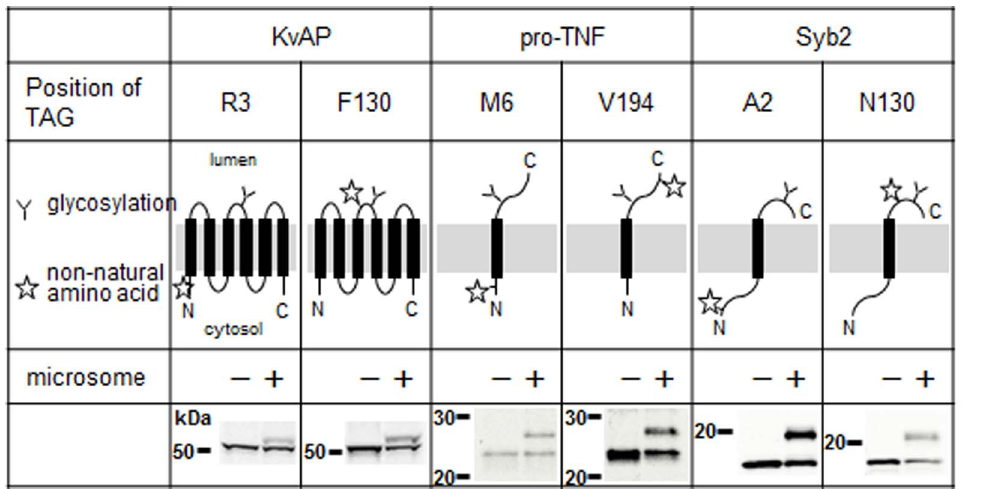
Fig. 6. Position-specific incorporation of fluorescent amino acids by the cell-free system. RNA templates encoding variants of KvAP, pro-TNF, or Syb2 were translated in the cell-free system supplemented with BODIPYFL-AF conjugated tRNA with or without the addition of Sf21microsomes (microsomes). The non-natural amino acids were incorporated into introduced TAG codon. The resulting proteins were subjected to SDS-PAGE (10-15% polyacrylamide) and detected with excitation at 488 nm and emission at 530 nm. The amber codon in the different constructs was substituted for the codon at the position corresponding to the listed amino acids (except for M6 in pro-TNF where the TAG codon was inserted as an additional codon after the M6 codon) and marked by a star in the